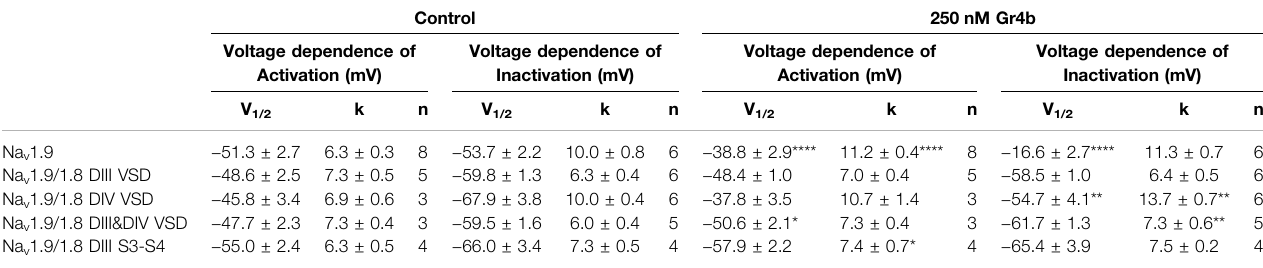
TABLE 3 | The effects of 250 nM Gr4b on activation of Na v 1.9 mutants. Control 250 nM Gr4b Voltage dependence of Voltage dependence of Activation (mV) Inactivation (mV)